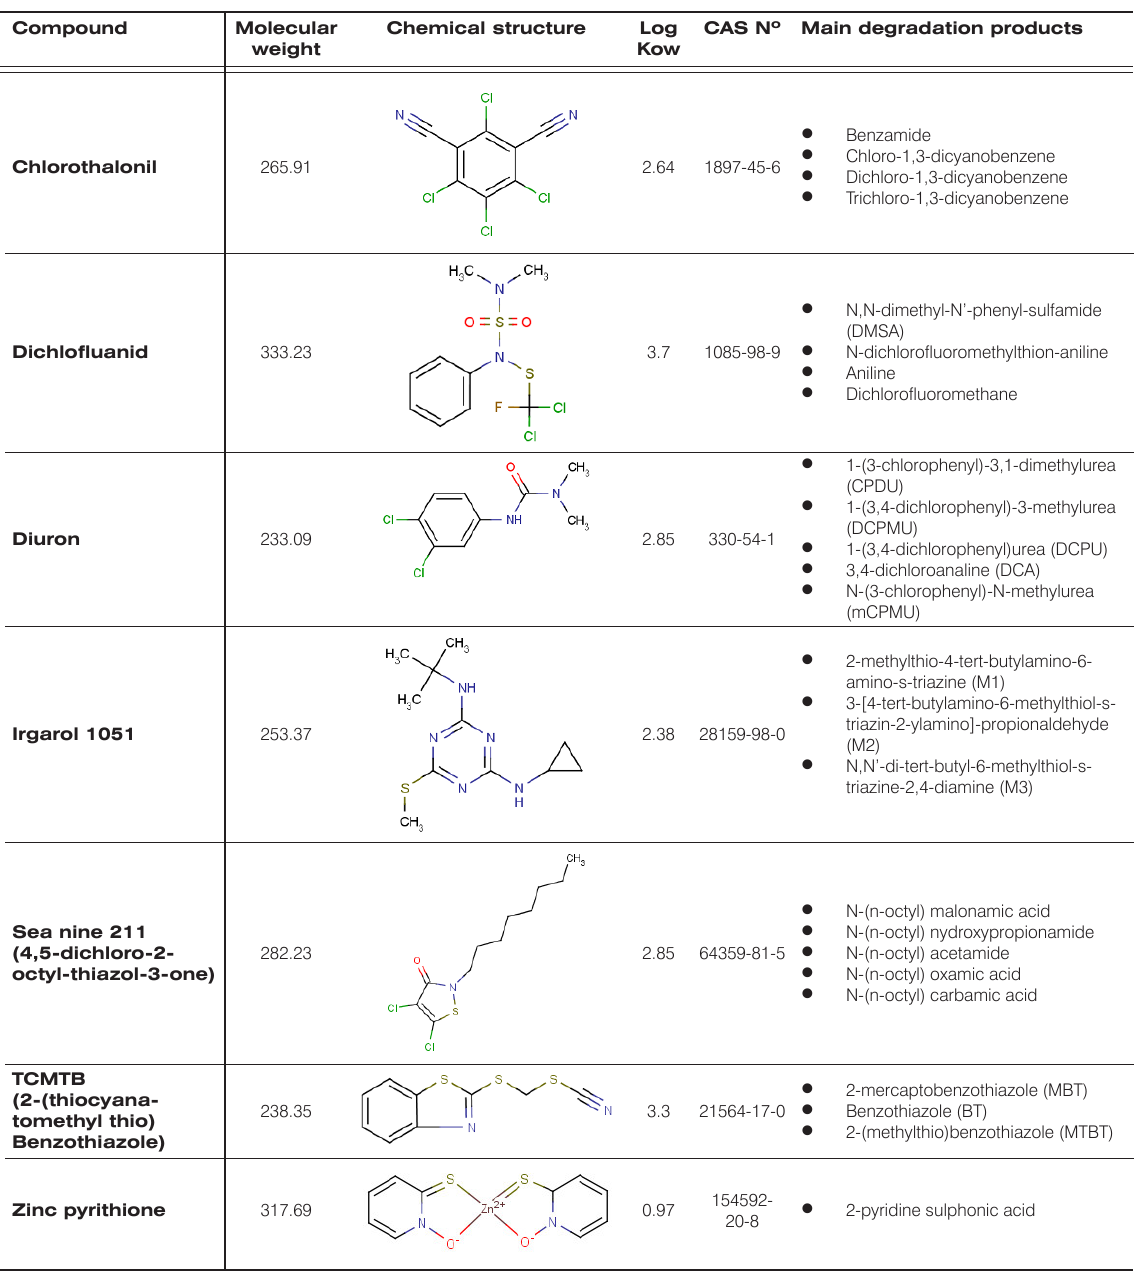
Table 1. Common booster biocides found in antifouling paints.